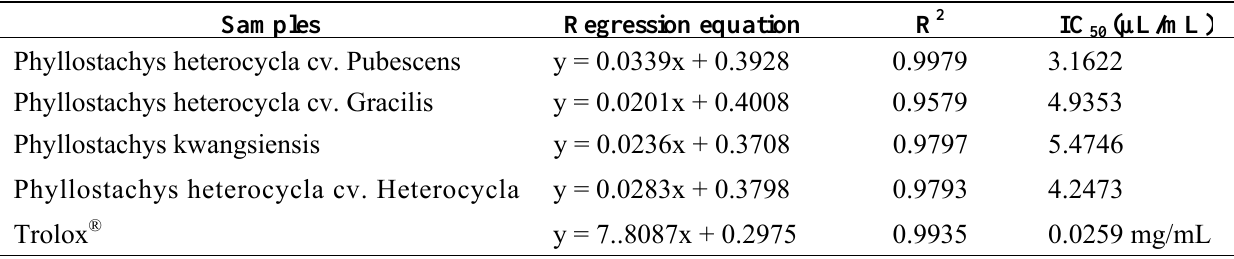
Table 2. Antioxidant activity of the essential oils of the four samples